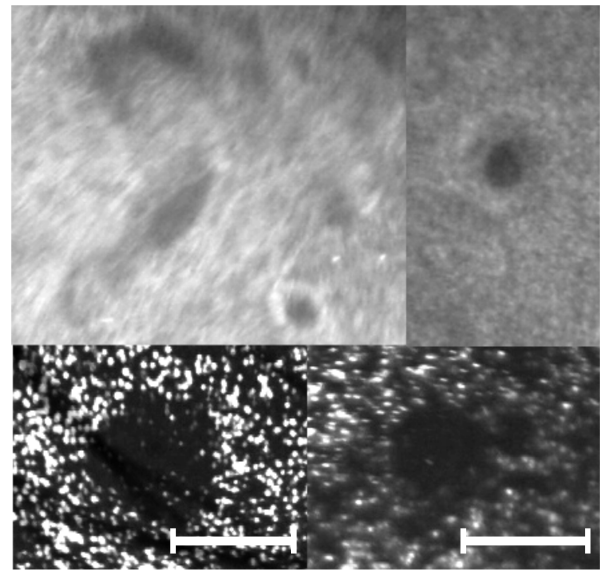
Figure 3. Example close-ups of variously shaped cloud voids ob- served at the UFS station with different camera–laser configura- tions. The 5cm long segment is shown to represent spatial scale assumed in the void size